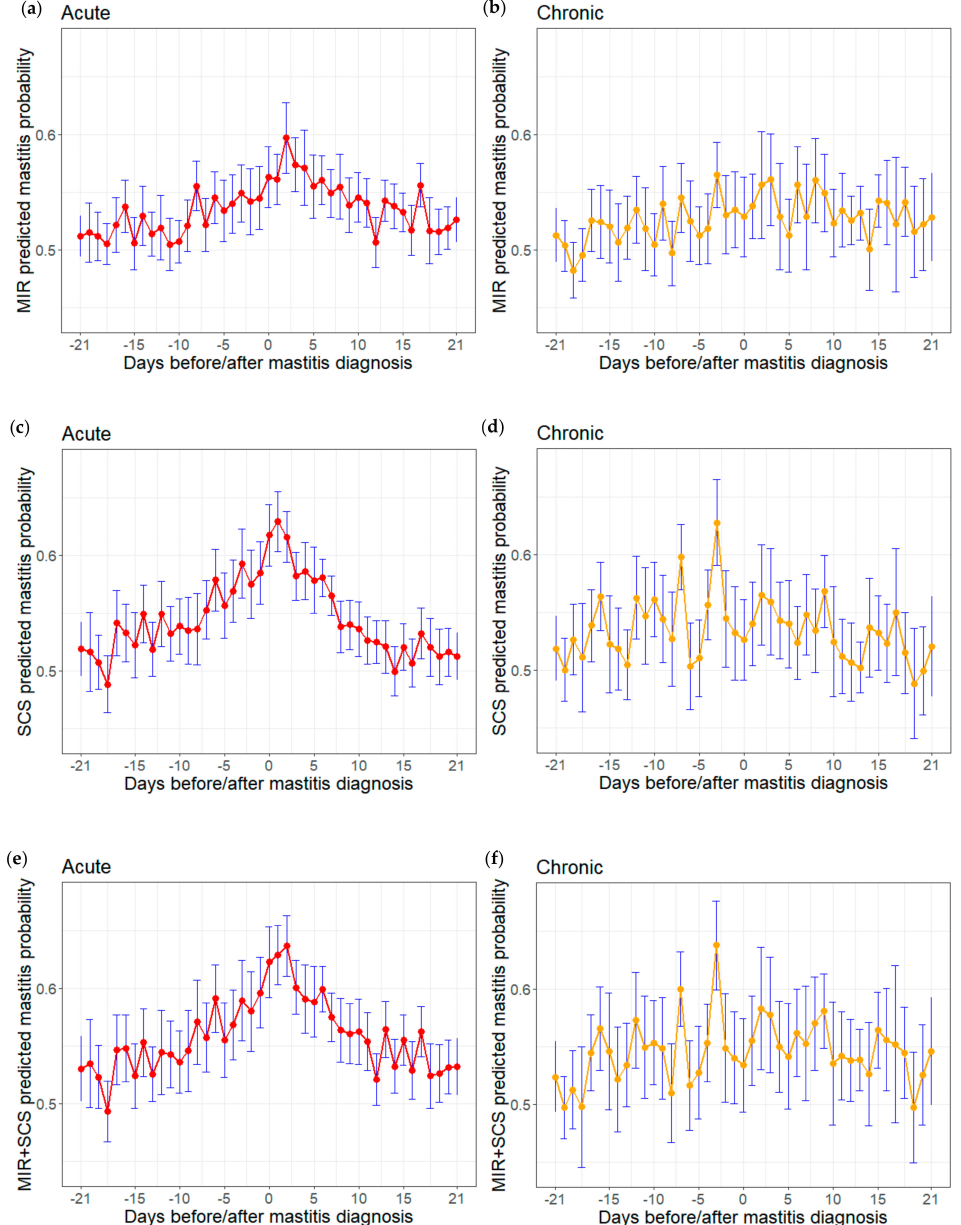
Figure 4. Predicted probabilities of acute ( left ) or chronic ( right ) mastitis for test-day records linked to diagnosis within 21 days. Predictions were generated using models based on MIR only, SCS only or both: MIR acute ( a ), MIR chronic ( b ), SCS acute ( c ), SCS chronic ( d ), MIR + SCS ( e ) and MIR + SCS chronic ( f ). Daily means with 95% confidence intervals are